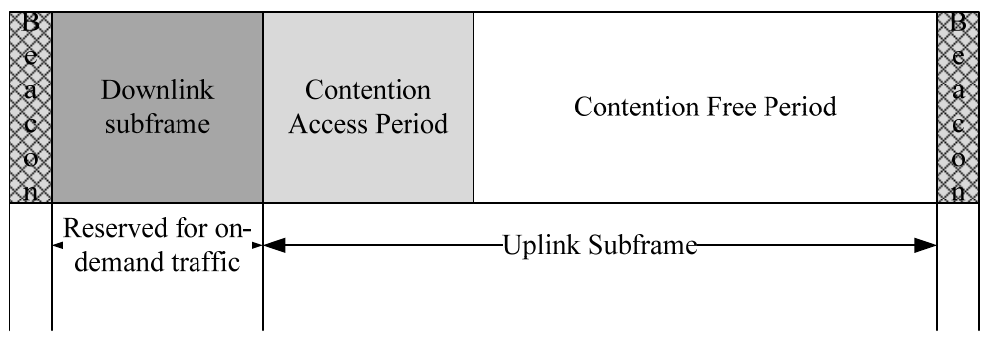
Figure 4. BodyMAC superframe